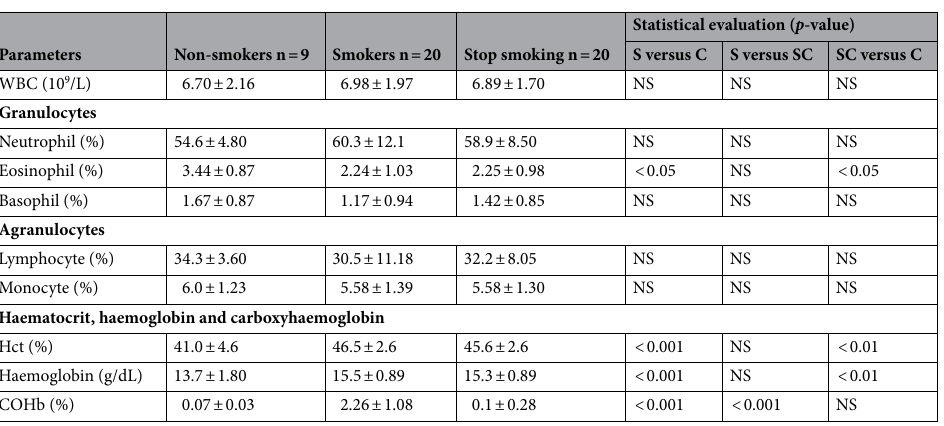
Table 3. The impact of smoking and smoking cessation on white blood cell counts, haematocrit, haemoglobin and carboxyhaemoglobin. All data are presented as mean ± SD; WBC: White blood cells; Hct: Haematocrit; COHb: Carboxyhaemoglobin; C: Non-smokers; S: smokers; SC: 14 days smoking cessation; NS: not significant.